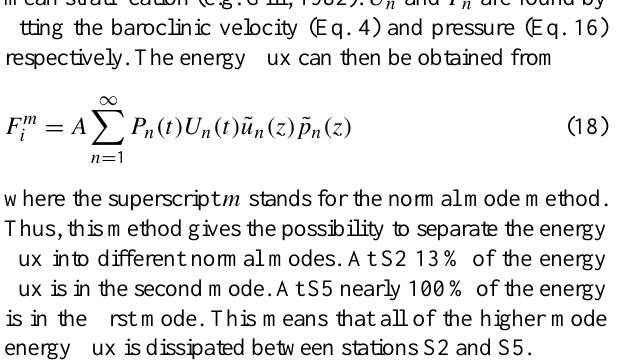
at station S2 and S5 obtained by using Eqs. (18)–(20). The perturbation pressure method (Eq. 15) is only applied at sta- tion S2 (not shown), and the results agree well with the re- sults from Eq. (18). The mean values during the whole mea- surement period are summed up in Table